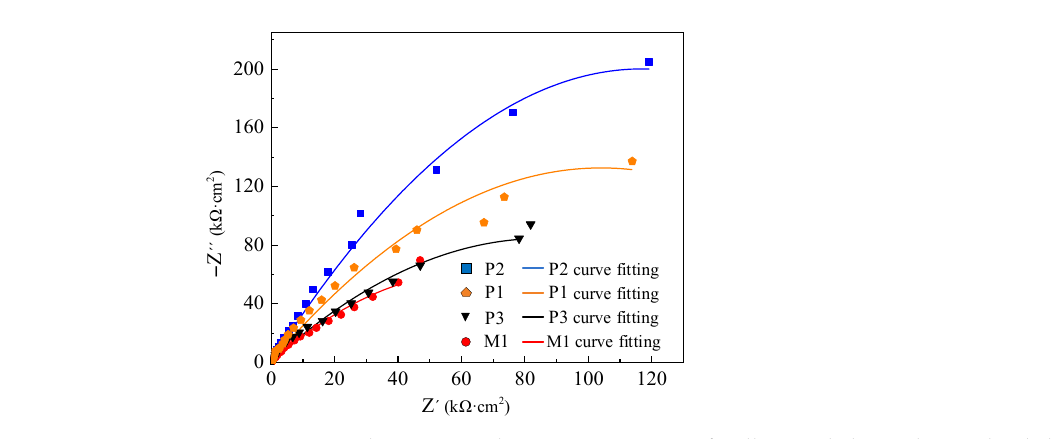
Figure 10. Impedance test and Nyquist spectrum of milling and electrochemical polishing samples.